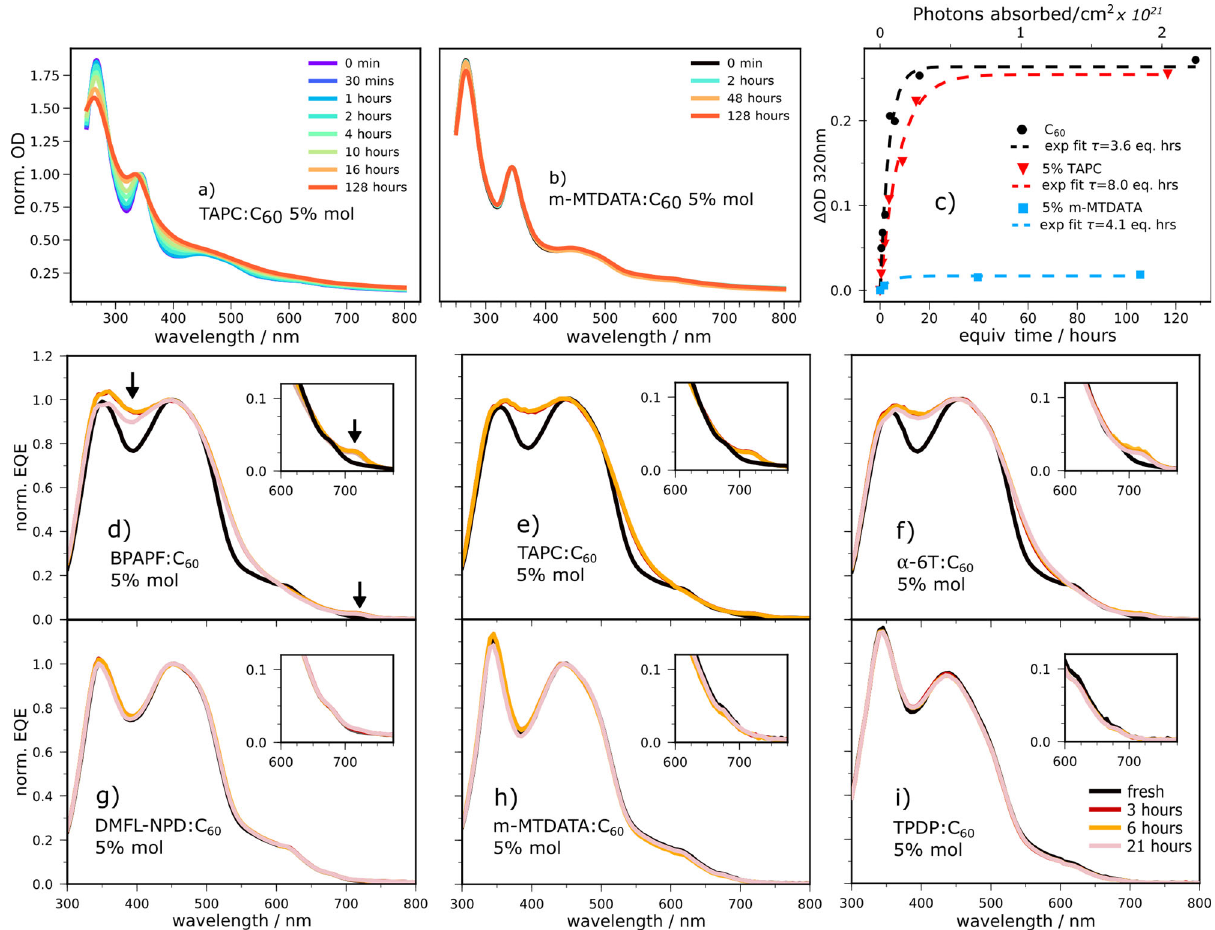
Fig. 1 Effect of light exposure on blend fi lms and full devices. a , b UV-vis absorption of dilute TAPC:C 60 and dilute m-MTDATA:C 60 solar cells exposed to white LED light under inert conditions. c Corresponding change in optical density (OD) at 320 nm associated with C 60 dimerization (neat C 60 UV-vis time series in Supplementary Methods Fig. 2). The time axis has been scaled to account for the different absorption of each fi lm (see Methods, neat C 60 1 h = 1 eq. h). d – i Change in EQE (normalized to the peak near 450 nm) of full devices with exposure to simulated sunlight (~1.5 suns intensity). The arrows in d indicate the 395 and 715 nm spectral features discussed in the text. Insets: detail around 715 nm. Data for F 4 ZnPc:C 60 can be found in Supplementary Fig.